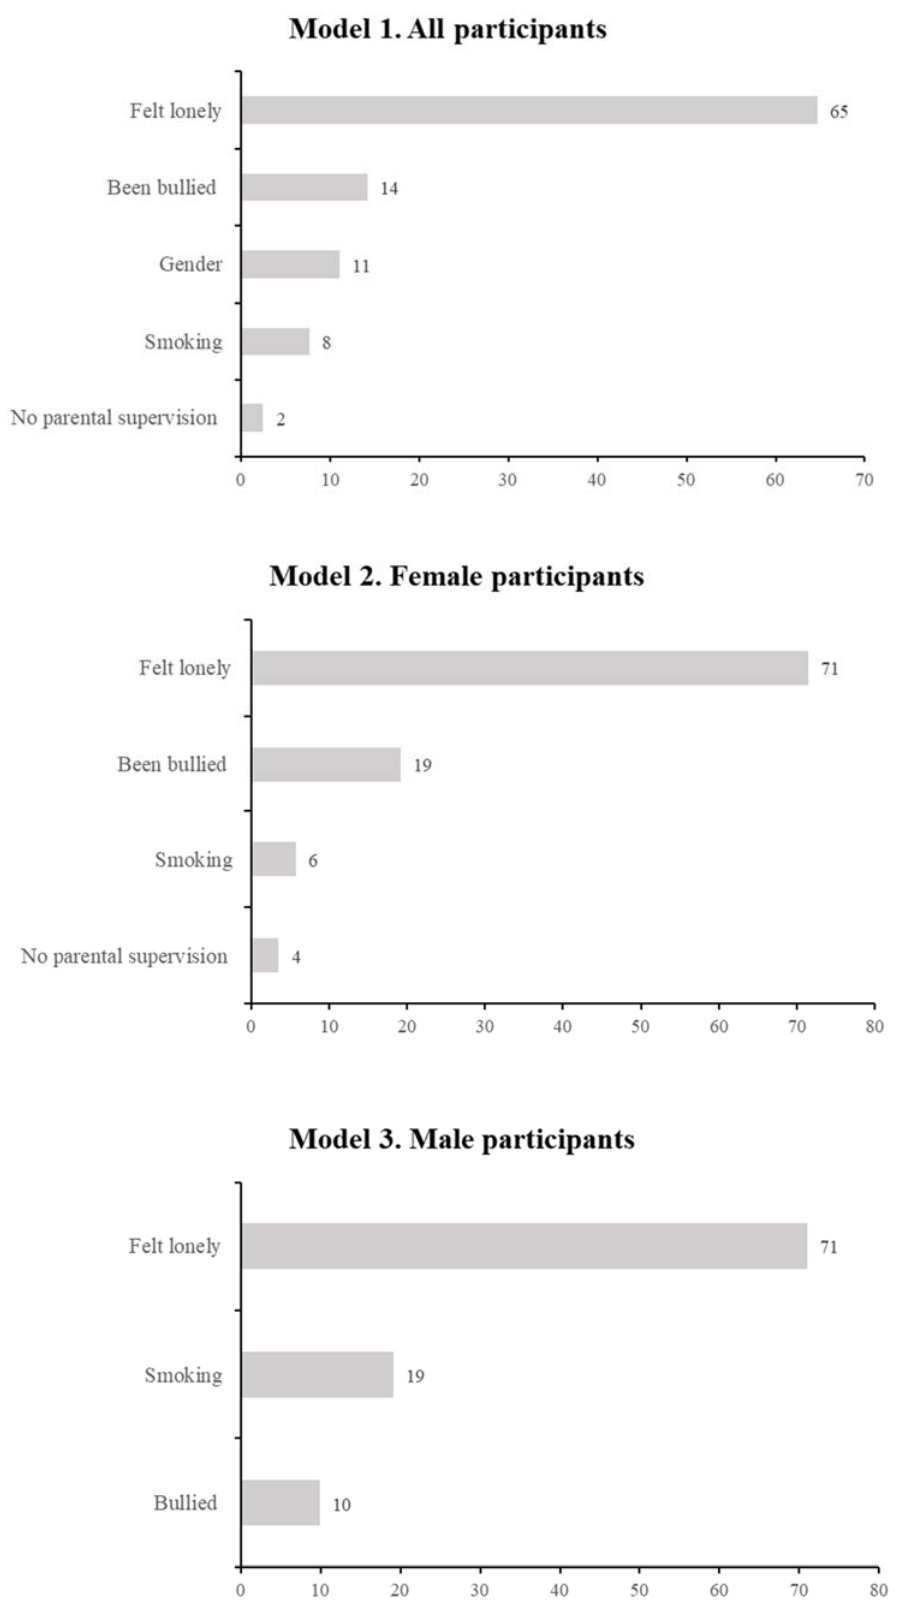
Figure 1. Rank order of important variables based on percentage (%) increase in r square, for each model.